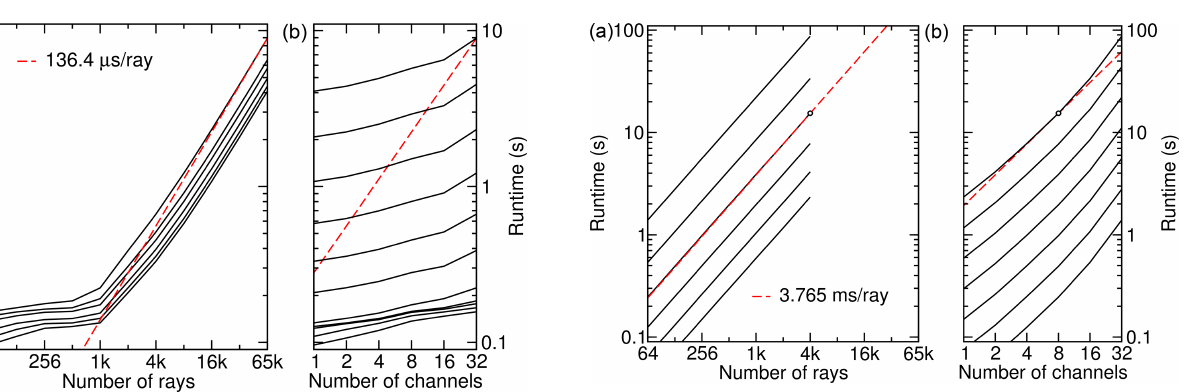
Figure 11. Scaling of the GPU runtime in the limb case. The left panel shows the runtime as a function of the number of ray paths for 1, 2, 4, 8, 16, and 32 channels. The right panel shows the same data in a different projection: the different black lines refer to 2 6 , 2 7 , ..., 2 16 ray paths from lowest to highest.